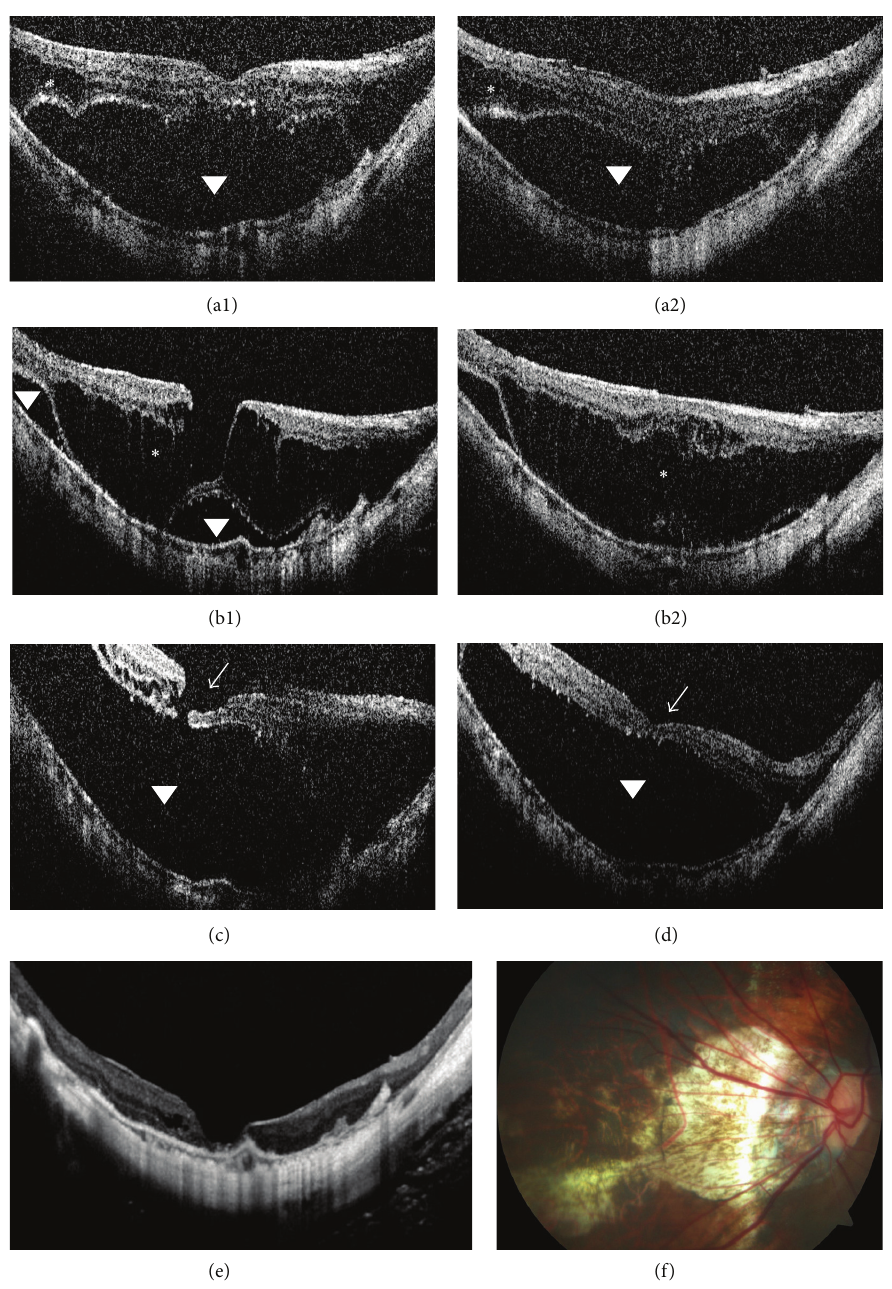
Figure 3: OCT findings in Case 2 during follow-up. (a1) Baseline OCT through the fovea reveals macular retinoschisis (asterisk) and foveal detachment (arrowhead). (a2) Baseline OCT taken inferior to the macula at baseline. (b1)-(b2) After 11 months, OCT reveals retinoschisis and a lamellar hole, accompanied by reduced foveal detachment. (c) After 25 months, OCT reveals that the foveal detachment has recurred and a small macular hole (arrowhead) has formed. (d) After 35 months, OCT reveals that retinal thickness has decreased and retinoschisis has improved. (e) After 65 months, OCT reveals retinal reattachment and a macular hole. (f) At 65 months, fundus photograph depicts patchy retinochoroidal atrophy in the posterior